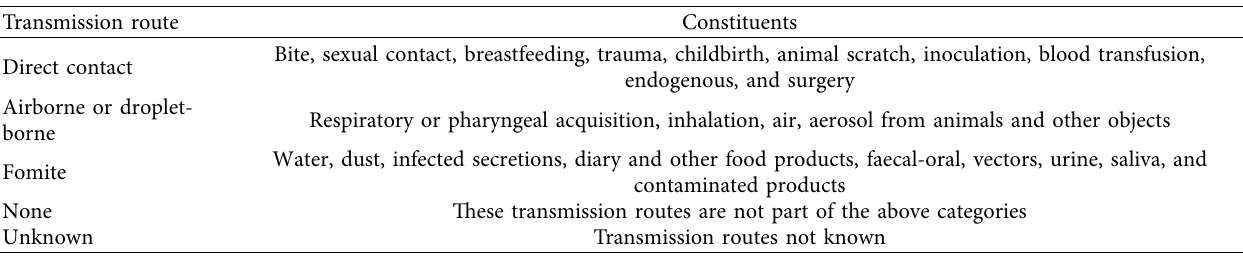
Table 2: The transmission routes and their constituents are adapted from GIDEON. None indicates that their transmission route is not part of the categories stated, while unknown indicates that the route of transmission is not known.